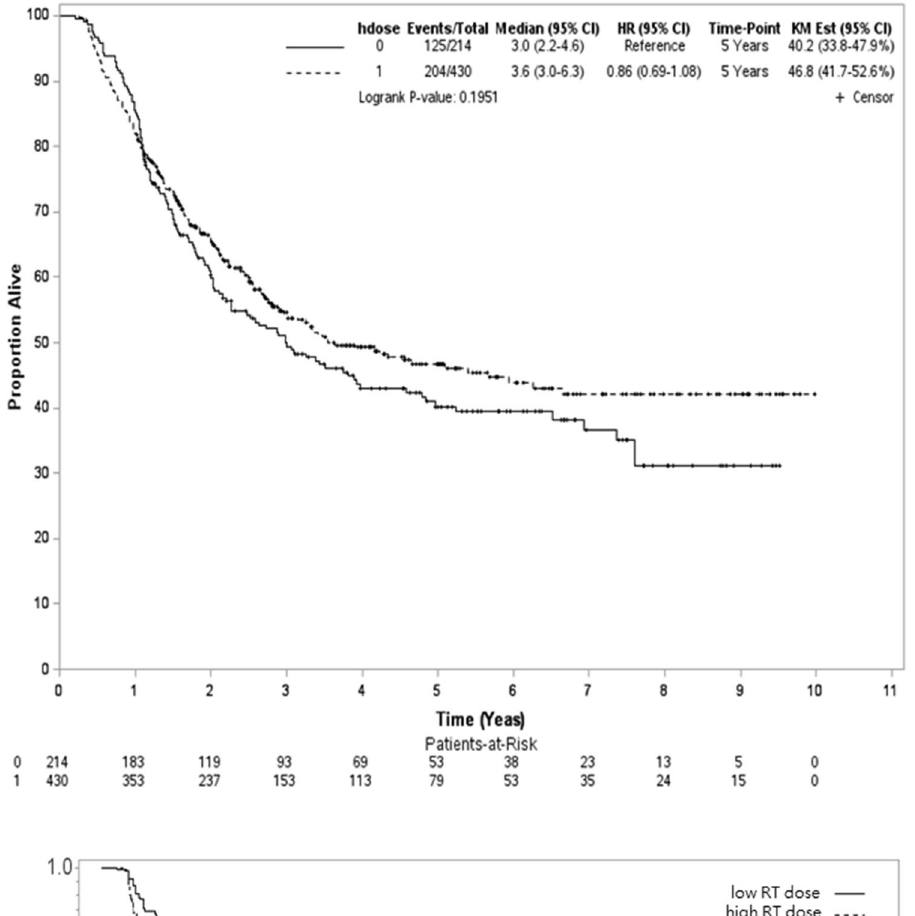
Fig. 3 The overlap weight- adjusted overall survival curve (in years) in the primary analysis. RT